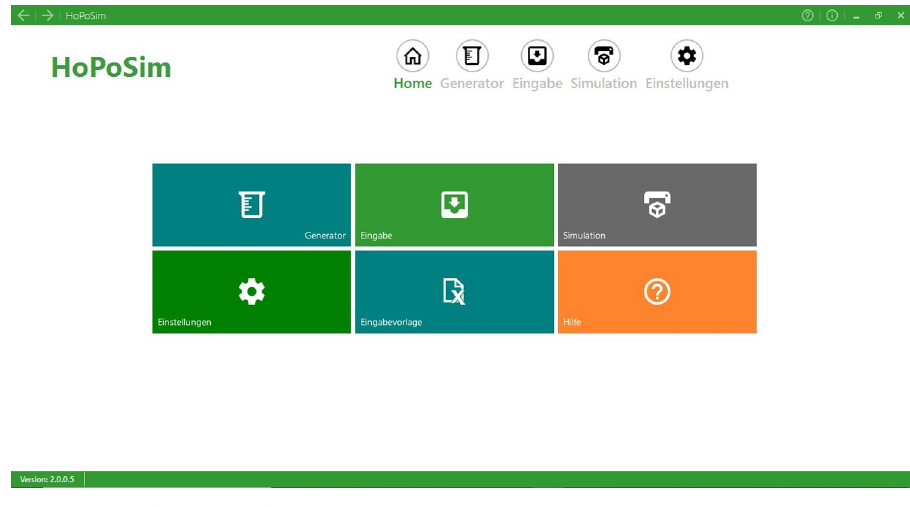
Fig 4. Main interface of the